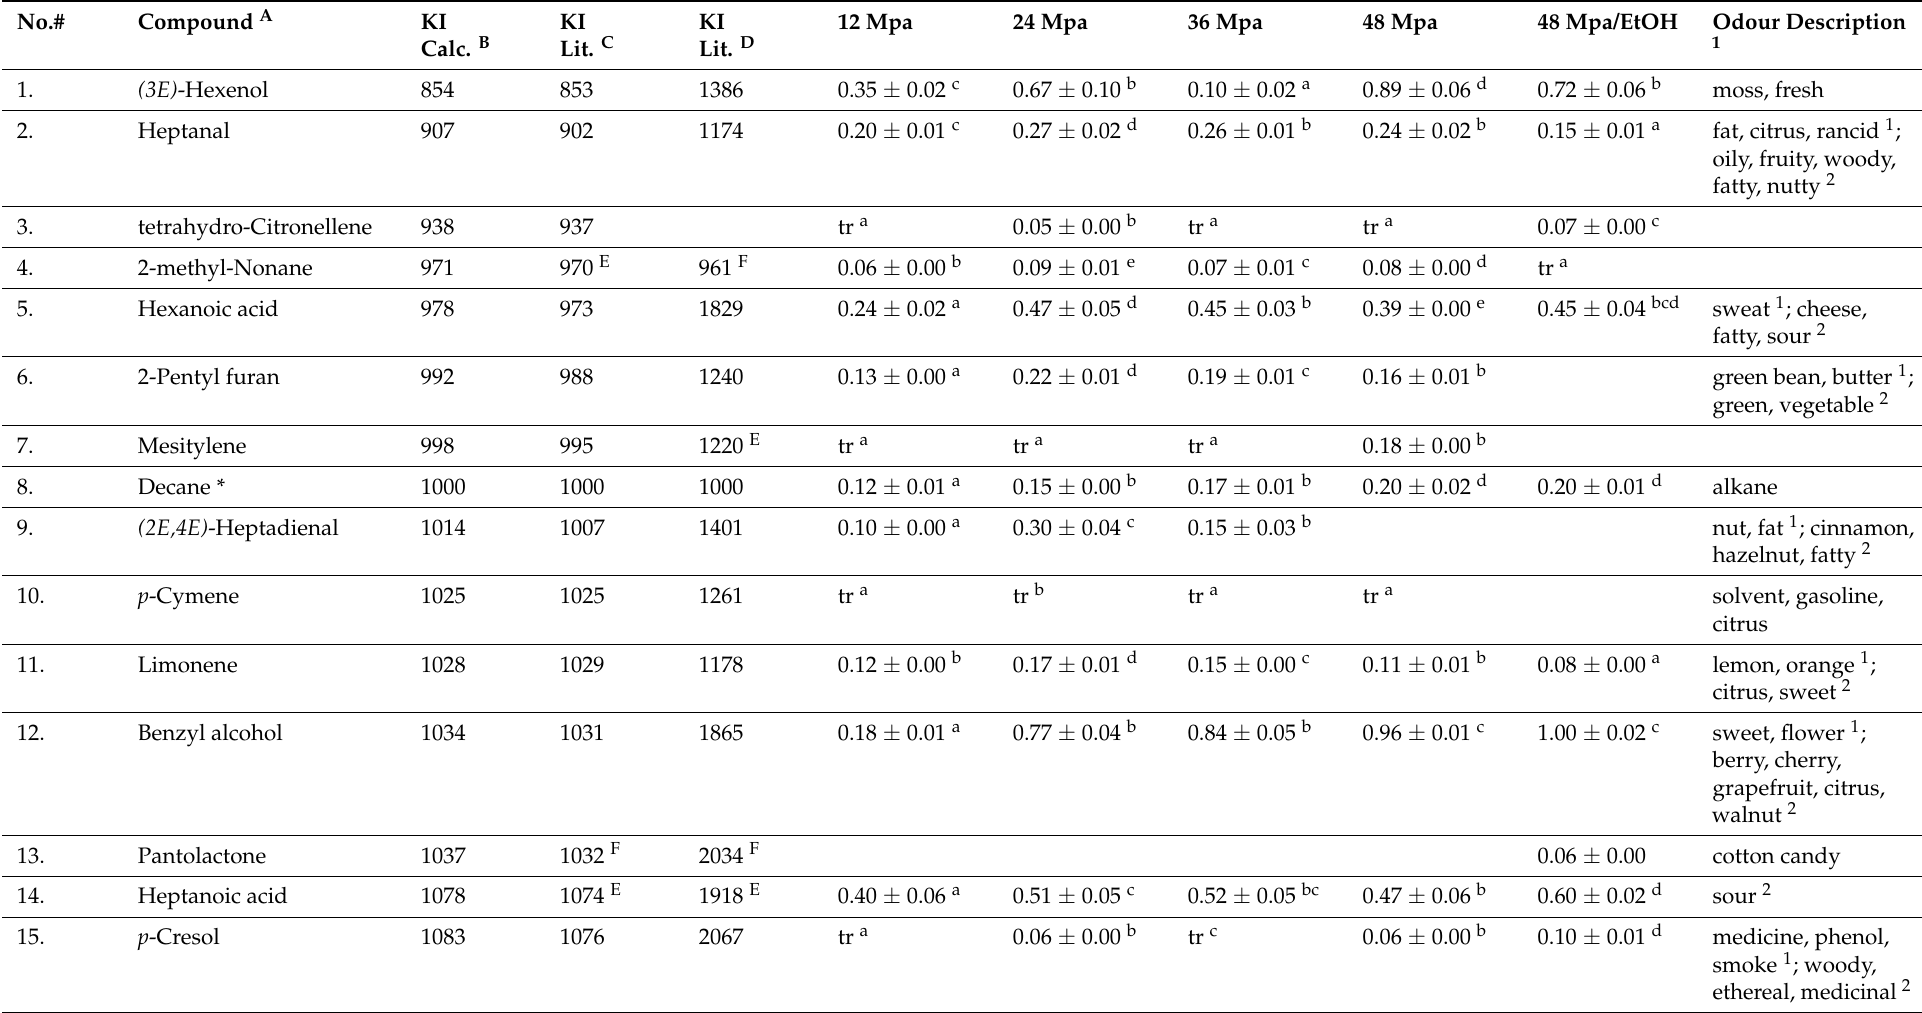
Table 2. Chemical composition of Narcissus poeticus SFE-CO 2 extracts, peak area percentage